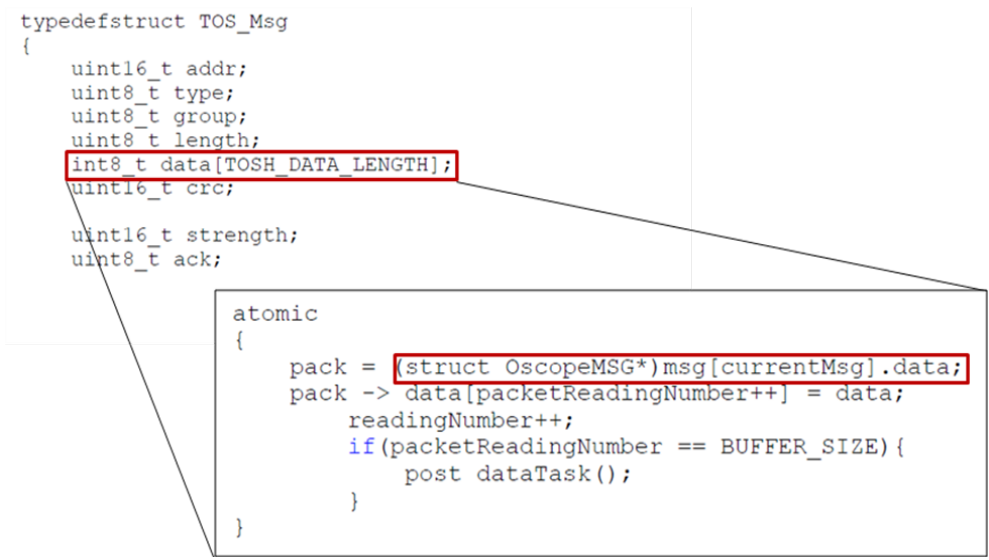
Figure 14. Sending message structure and data